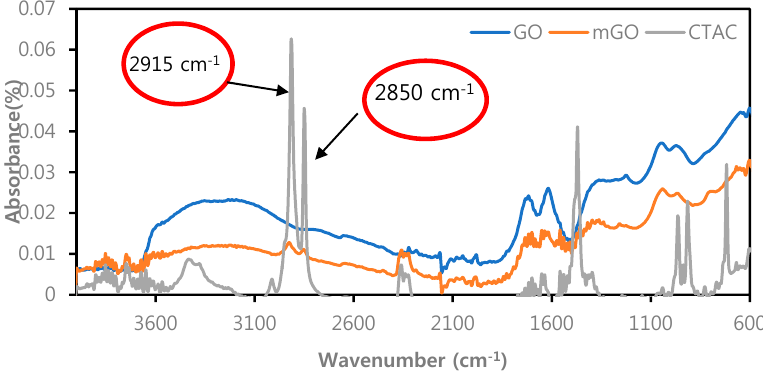
Figure 2. FTIR of GO, mGO, and cetyltrimethylammonium chloride (CTAC) indicates that the mGO is successfully prepared.